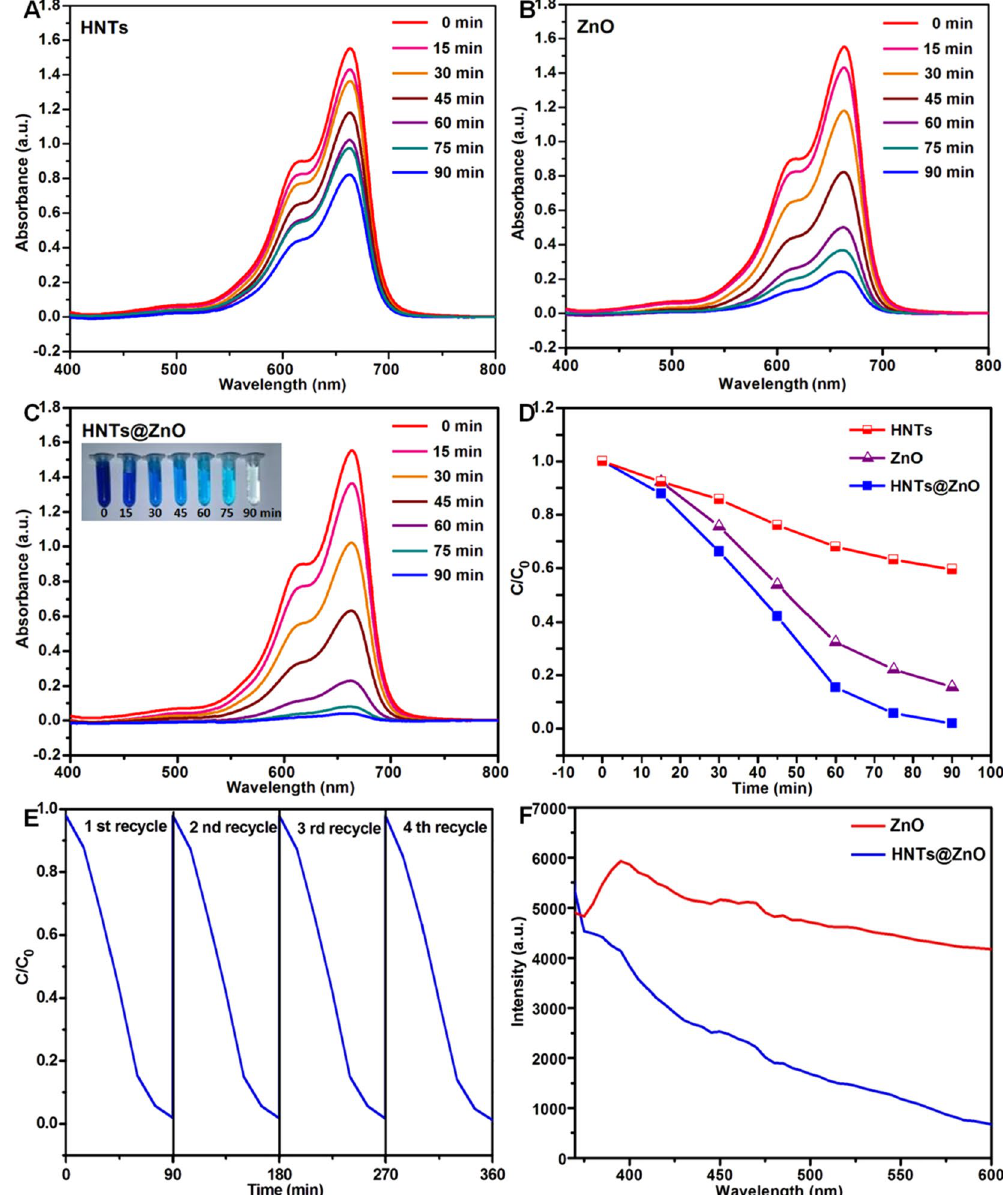
Figure 7. ( A ) Photocatalytic degradation curves of MB over HNTs, ZnO and HNTs@ZnO under ultraviolet light, and ( B – D ) the corresponding kinetic simulation curves. The Inset in ( C ) shows the corresponding solution color. ( E ) Effect of cycles of HNTs@ZnO nanocomposites on degradation of MB. ( F ) Photoluminescence (PL) spectra of ZnO and